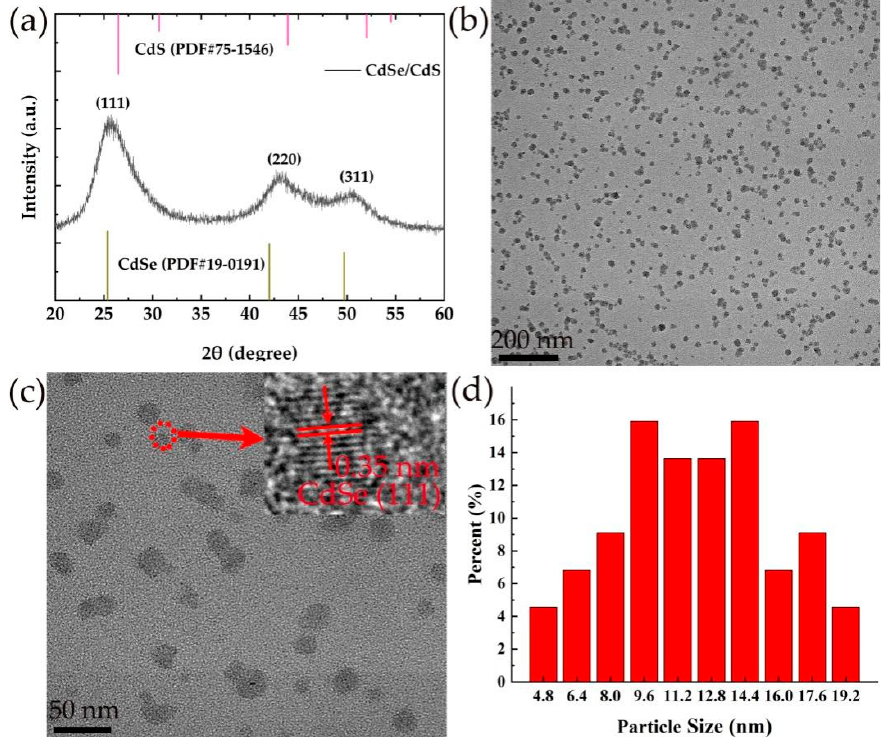
Figure 2. ( a ) XRD of CdSe/CdS QDs, ( b , c ) TEM images of CdSe/CdS QDs in different scale, and ( d ) size distribution of CdSe/CdS QDs.